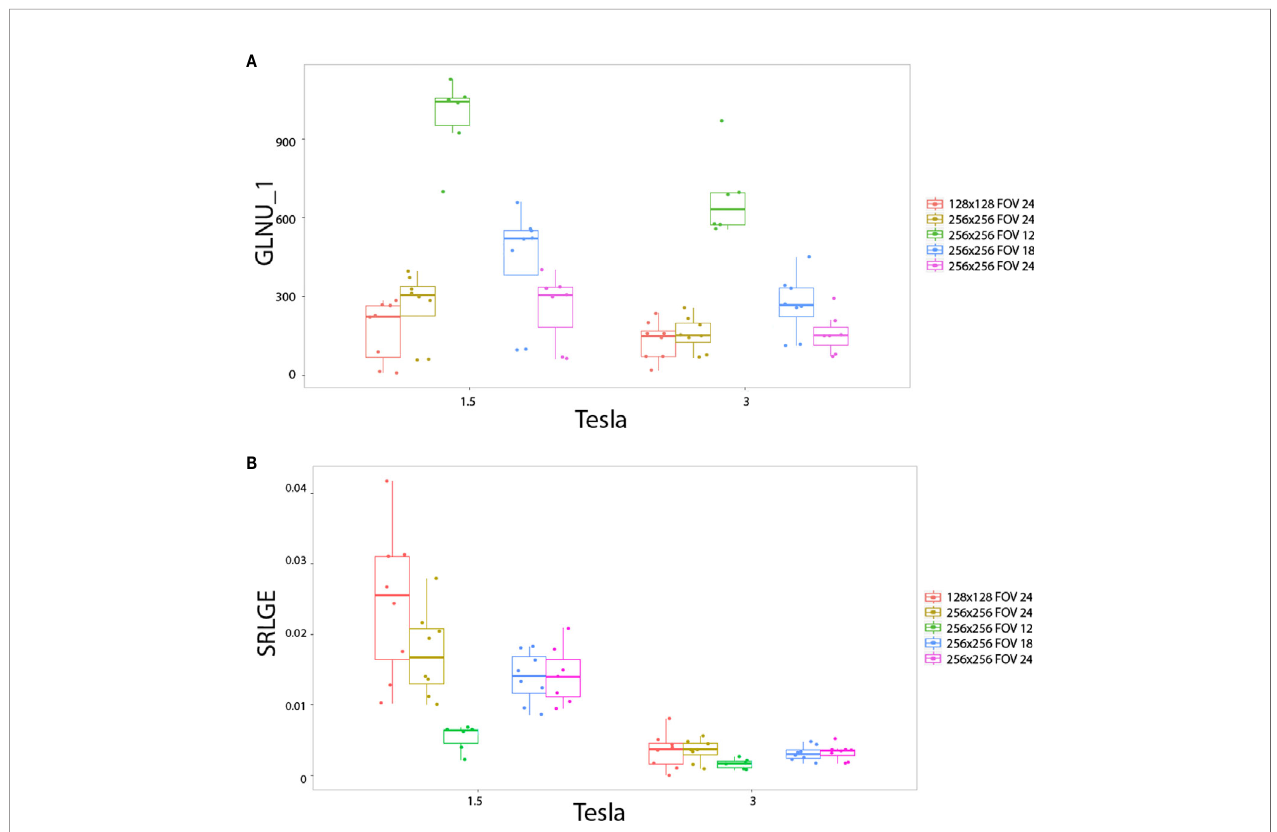
FIGURE 5 | In vitro parameters value according to magnetic fi eld strengh and pixel size: for GLNU_1 (A) and SRLGE (B) . Texture features extracted to the heterogeneous phantoms. Each colored dot groups and related box plot shows the value of GLNU_1 (A) and SRLGE (B) calculated from repeated phantom MRI acquisition (one dot per MRI acquisition) with different pixel size (one color per matrix/FOV couple), respectively, at 1.5 and 3T.